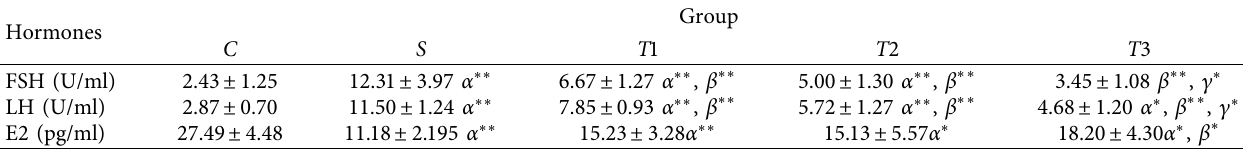
Table 4: Mean ± SEM of FSH, LH, and E2 in different